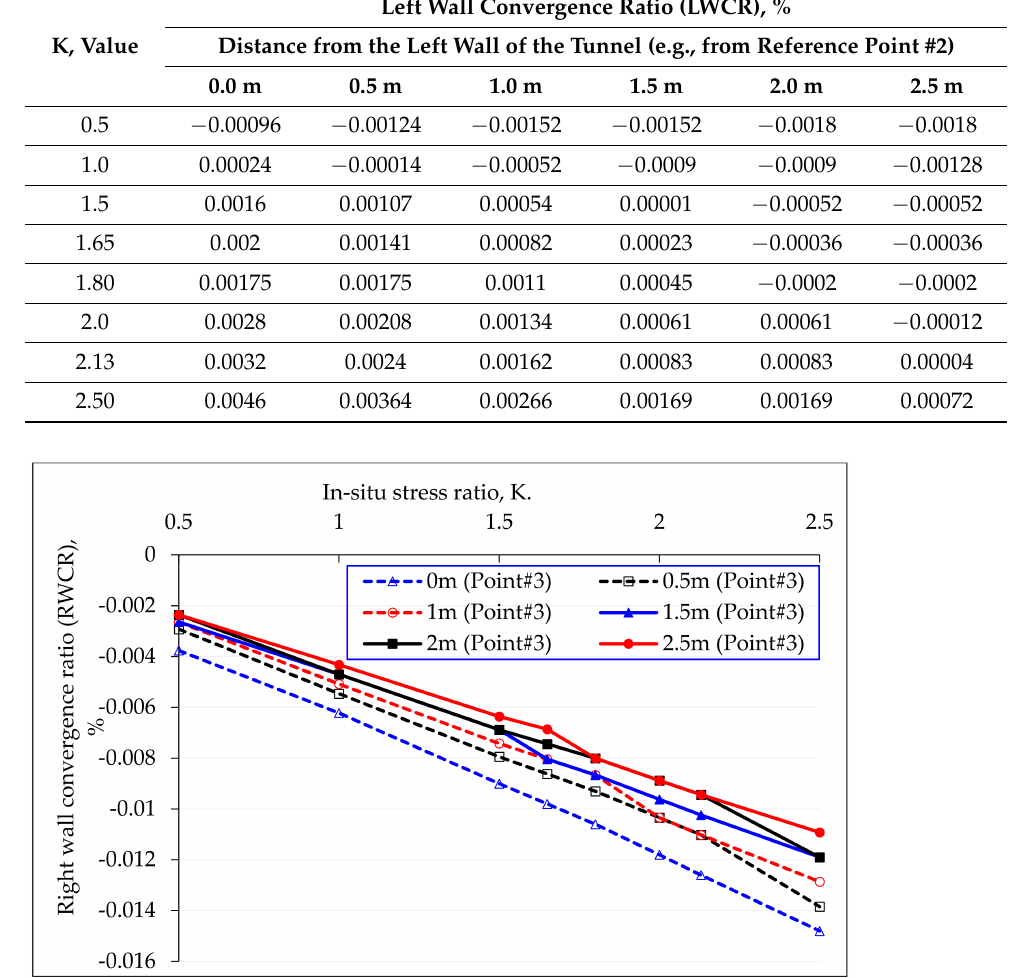
Figure 3. Ratio of convergence occurs in the tunnel right wall (RWCR) at various in situ stress ratios monitored at different lateral distances from tunnel boundary (e.g., point